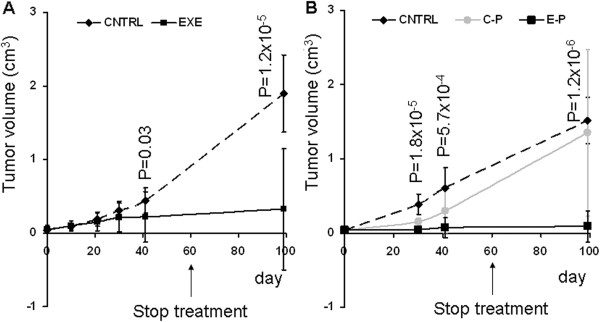
Exemestane alone and in association with pemetrexed blocks growth of MPM tumor xenografts. A, Graphs represent 100 days of tumor volume measurements in mice treated (EXE) or not (CNTRL) with exemestane for 60 days. B, Graphs represent 100 days of tumor volume measurements in mice upon cisplatin-pemetrexed (C-P) or exemestane-pemetrexed (E-P) treatment for 60 days versus non treated mice (CNTRL). Each value represents the average and standard deviation, P is the p value assessed using 2-tailed Student’s test.